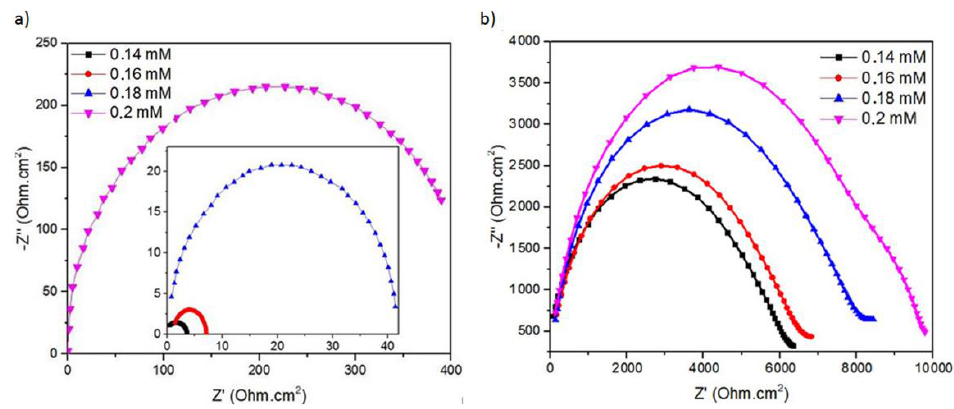
Figure 9. The experiment results of the EIS measurement with varying concentrations of the PBS+BSA medium using ( a ) the Ag thin film and ( b ) the Ag nanosquare array.